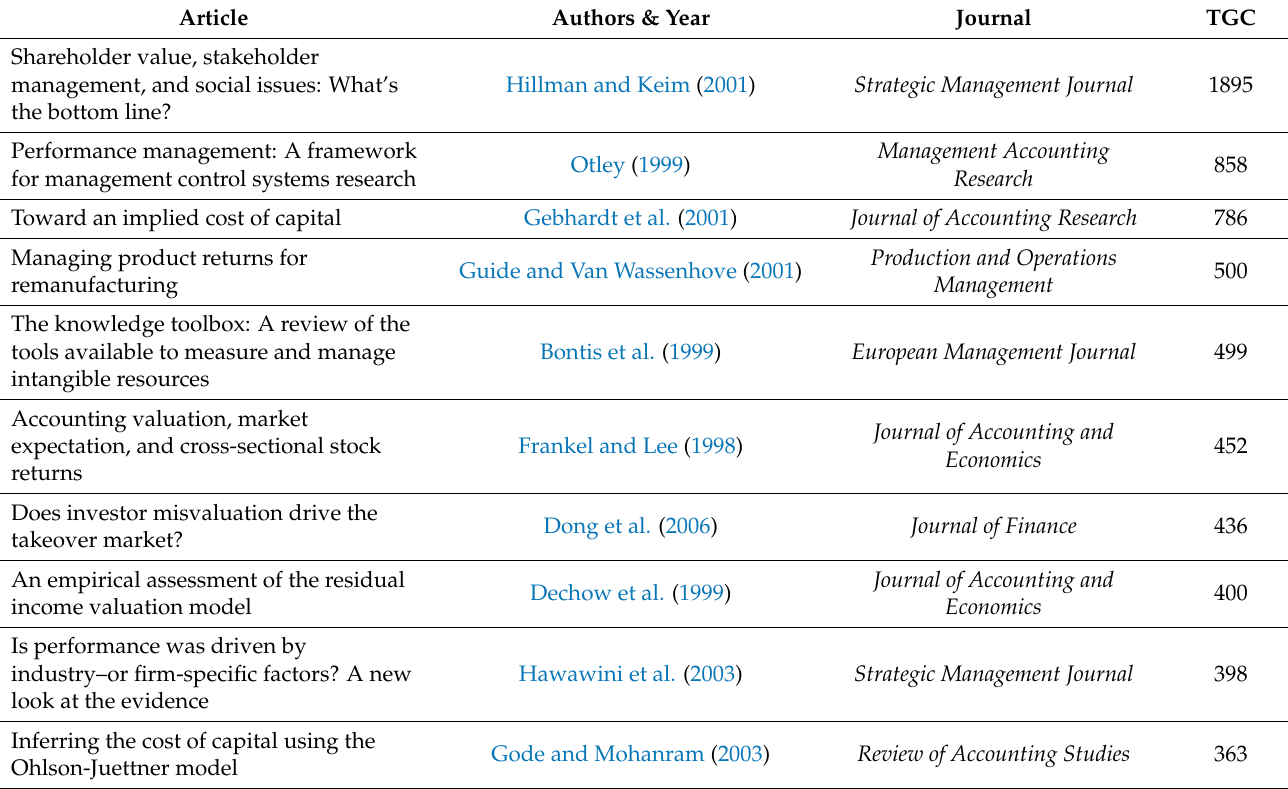
Table 3. Leading Articles in EVA Research Domain based on Total Global